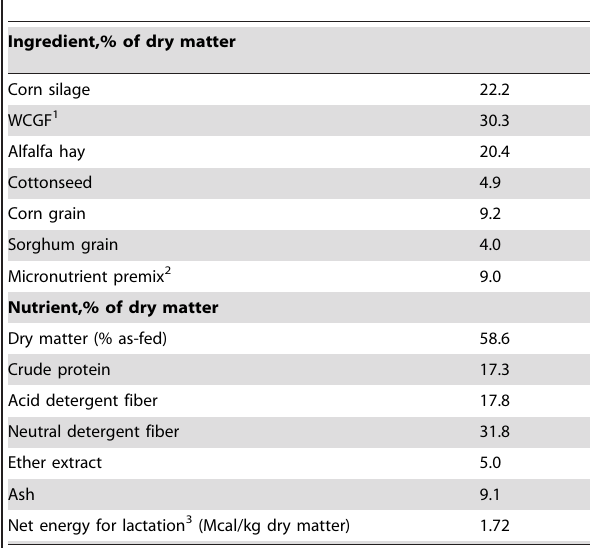
Table 1. Ingredient and nutrient composition of the